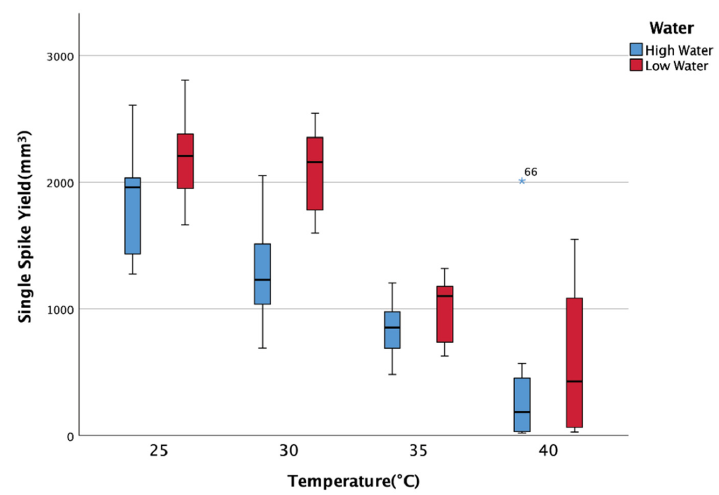
Figure 24. Spike yields according to different temperature and water conditions. Temperature and